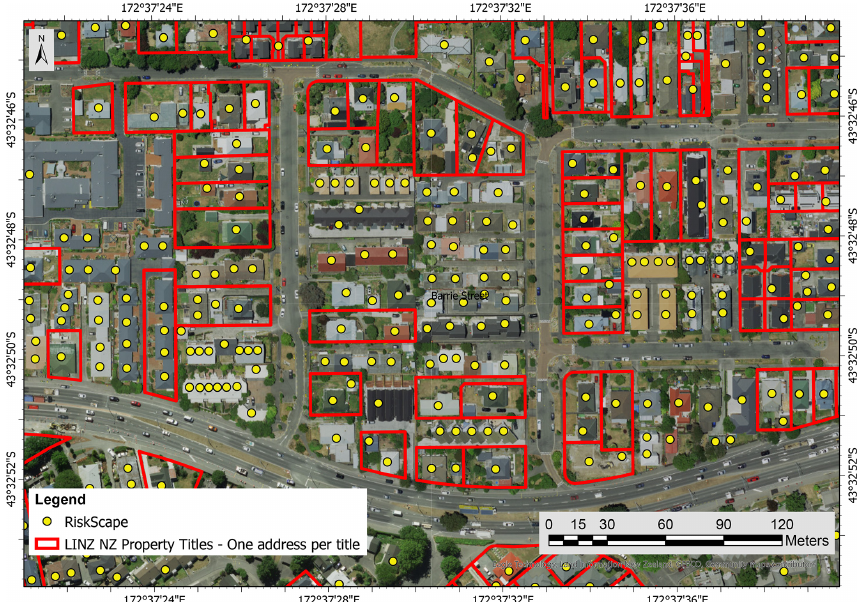
Figure 4. Satellite view of an urban block in Christchurch with RiskScape points and selected LINZ NZ Property Titles (background layer from Eagle Technology Group Ltd; NZ Esri